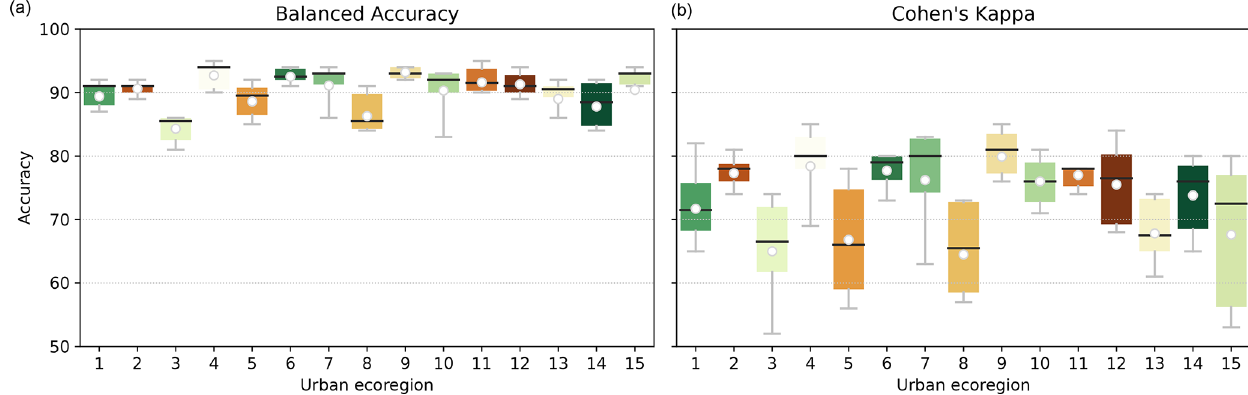
Figure I1. Balanced accuracy (a) and Cohen’s kappa (b) for the 150 global LCZ FUA regions in terms of built-up land, stratified by urban ecoregion (colours as in Fig. 3). Boxes and grey whiskers span the 25th–75th and 5th–95th percentiles respectively. The means and medians are indicated by the white dots and black lines respectively.